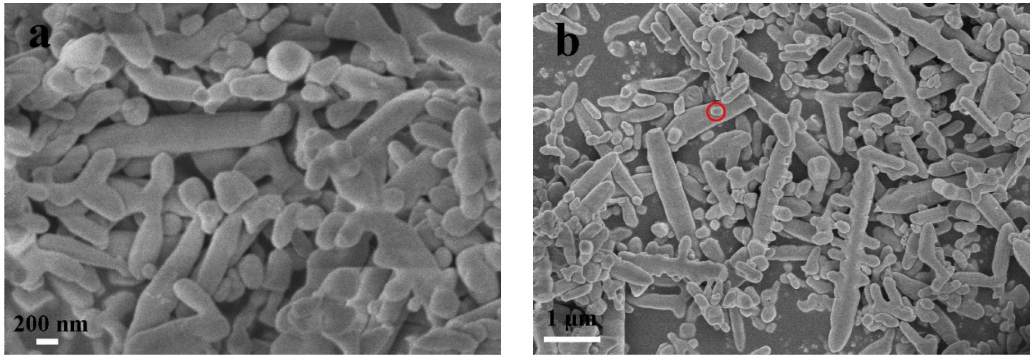
Figure 2. FESEM images of ( a ) BiVO 4 and ( b )